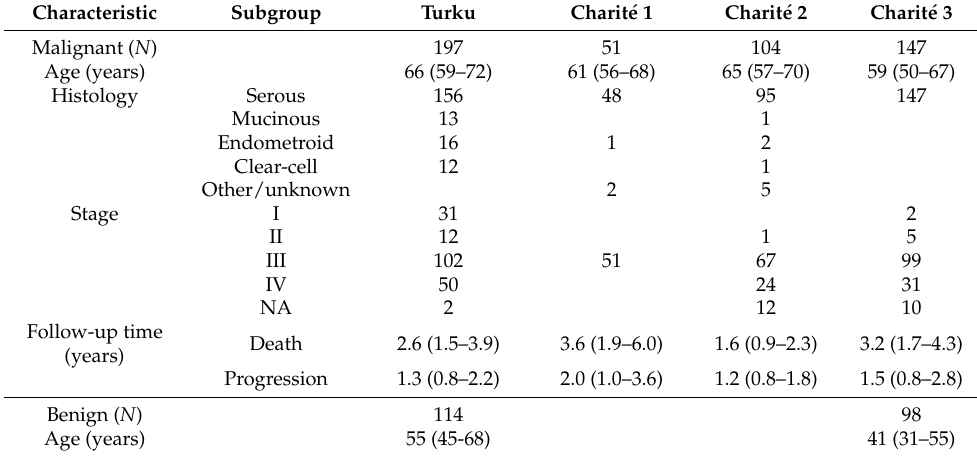
Table 1. Clinical characteristics of the study